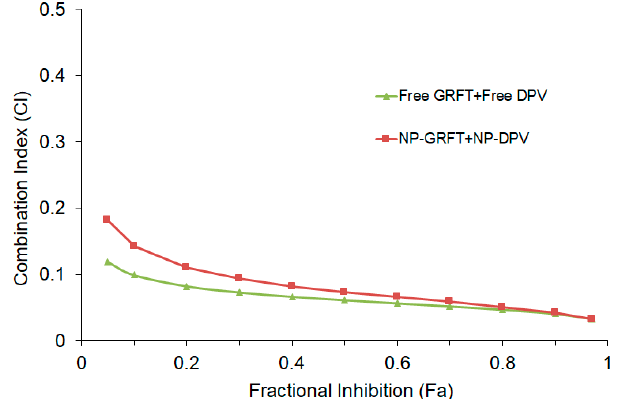
Figure 9. Combination index (CI) of free GRFT with free DPV or GRFT nanoparticles (NP-GRFT) with DPV nanoparticles (NP-DPV) were quantified using the TZM-bl infectivity assay. CI < 1, = 1, and >1 indicate synergistic, additive, and antagonistic effects, respectively. Combination of GRFT and DPV at a 1:8 molar ratio (GRFT:DPV) demonstrated very strong synergism, with CI at 50% inhibition (CI 50 ) of 0.086 and 0.066 for unformulated and nanoparticle combinations respectively. CI 0.90–1.10: nearly additive; CI 0.85–0.95: slight synergism; CI 0.7–0.85: moderate synergism; CI 0.3–0.7: synergism; CI 0.1–0.3 strong synergism; CI < 0.1: Very strong synergism.